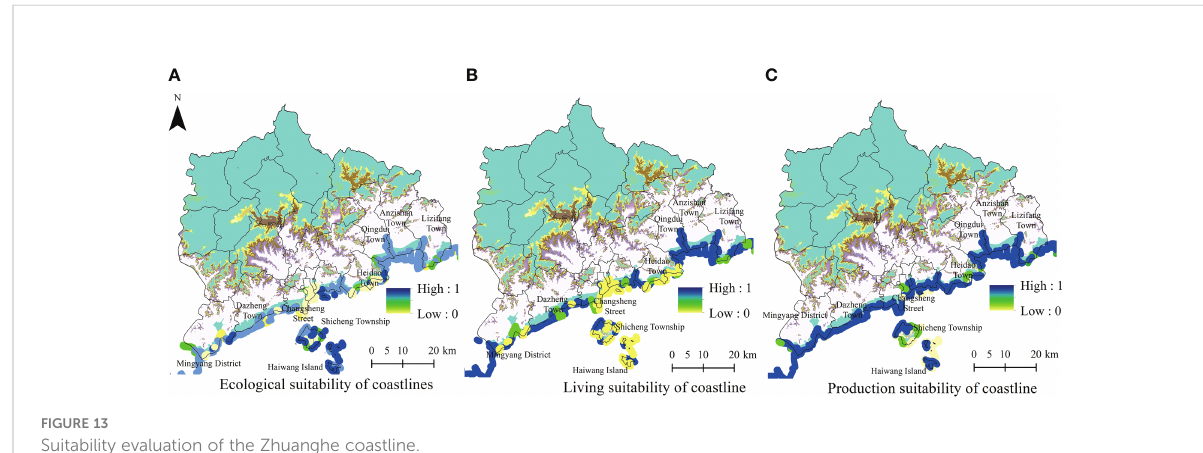
FIGURE 13 Suitability evaluation of the Zhuanghe